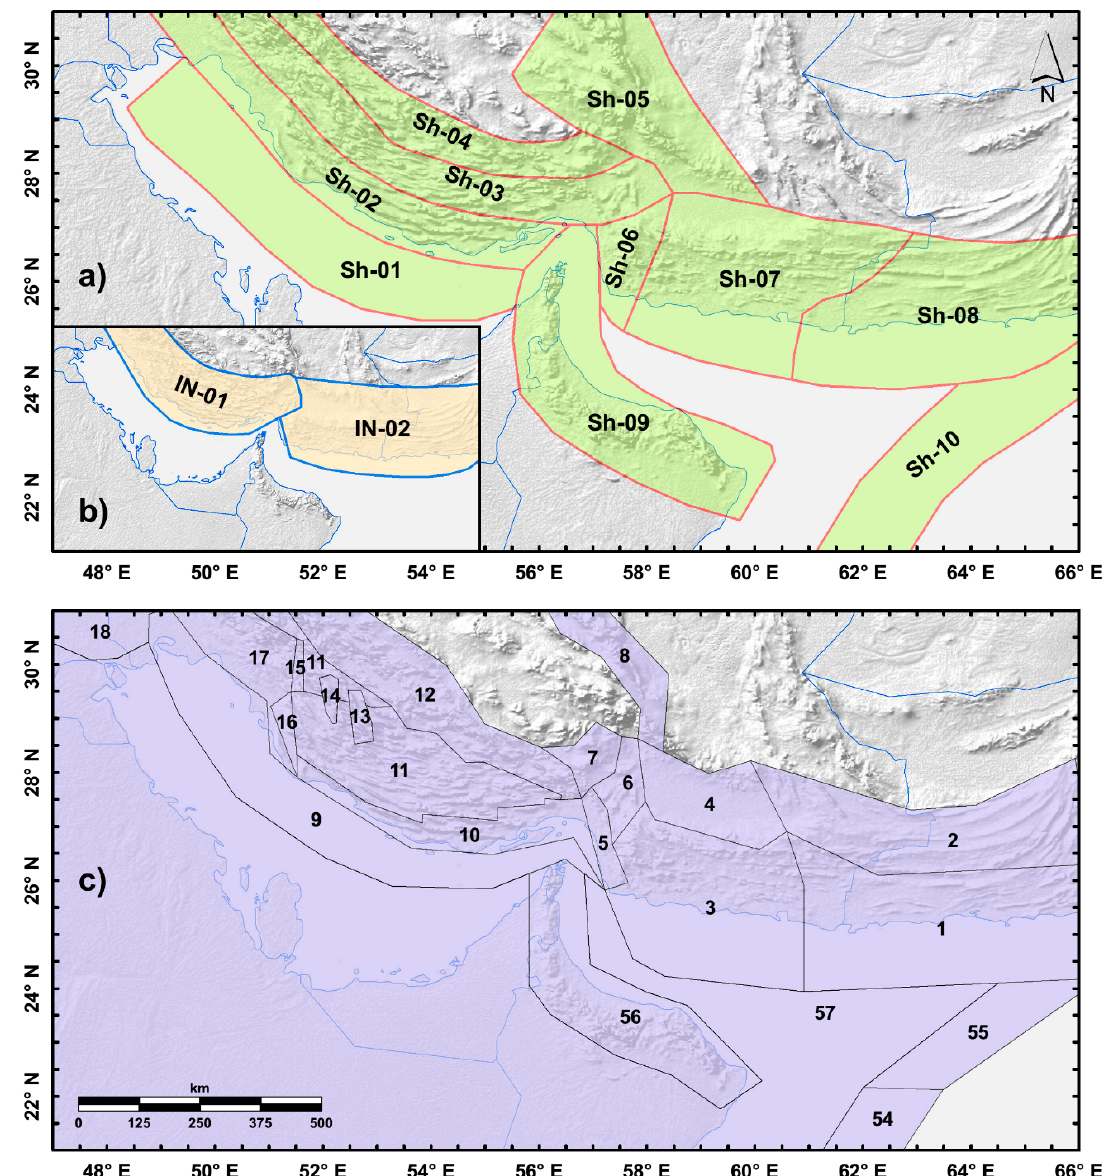
Figure 2. The considered two zoning seismic source models in the current assessment. ( a ) and ( b ) shallow and intermediate-depth sources, respectively, by Sawires et al. [2], and ( c ) model by El-Hussain et al. [65].